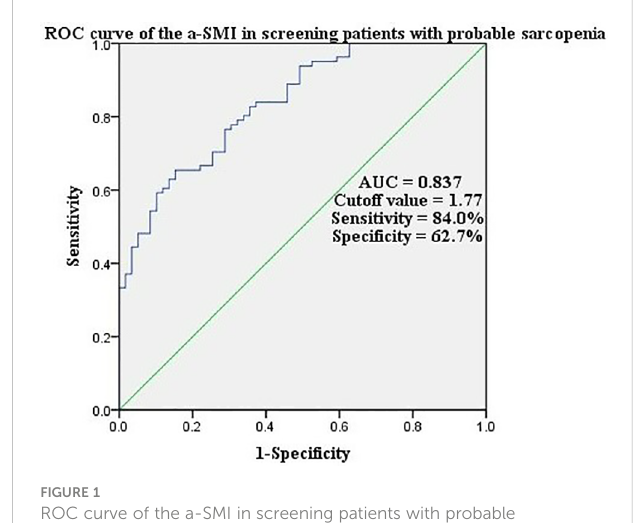
FIGURE 3 ROC curve of the new diagnostic approach in elderly patients with